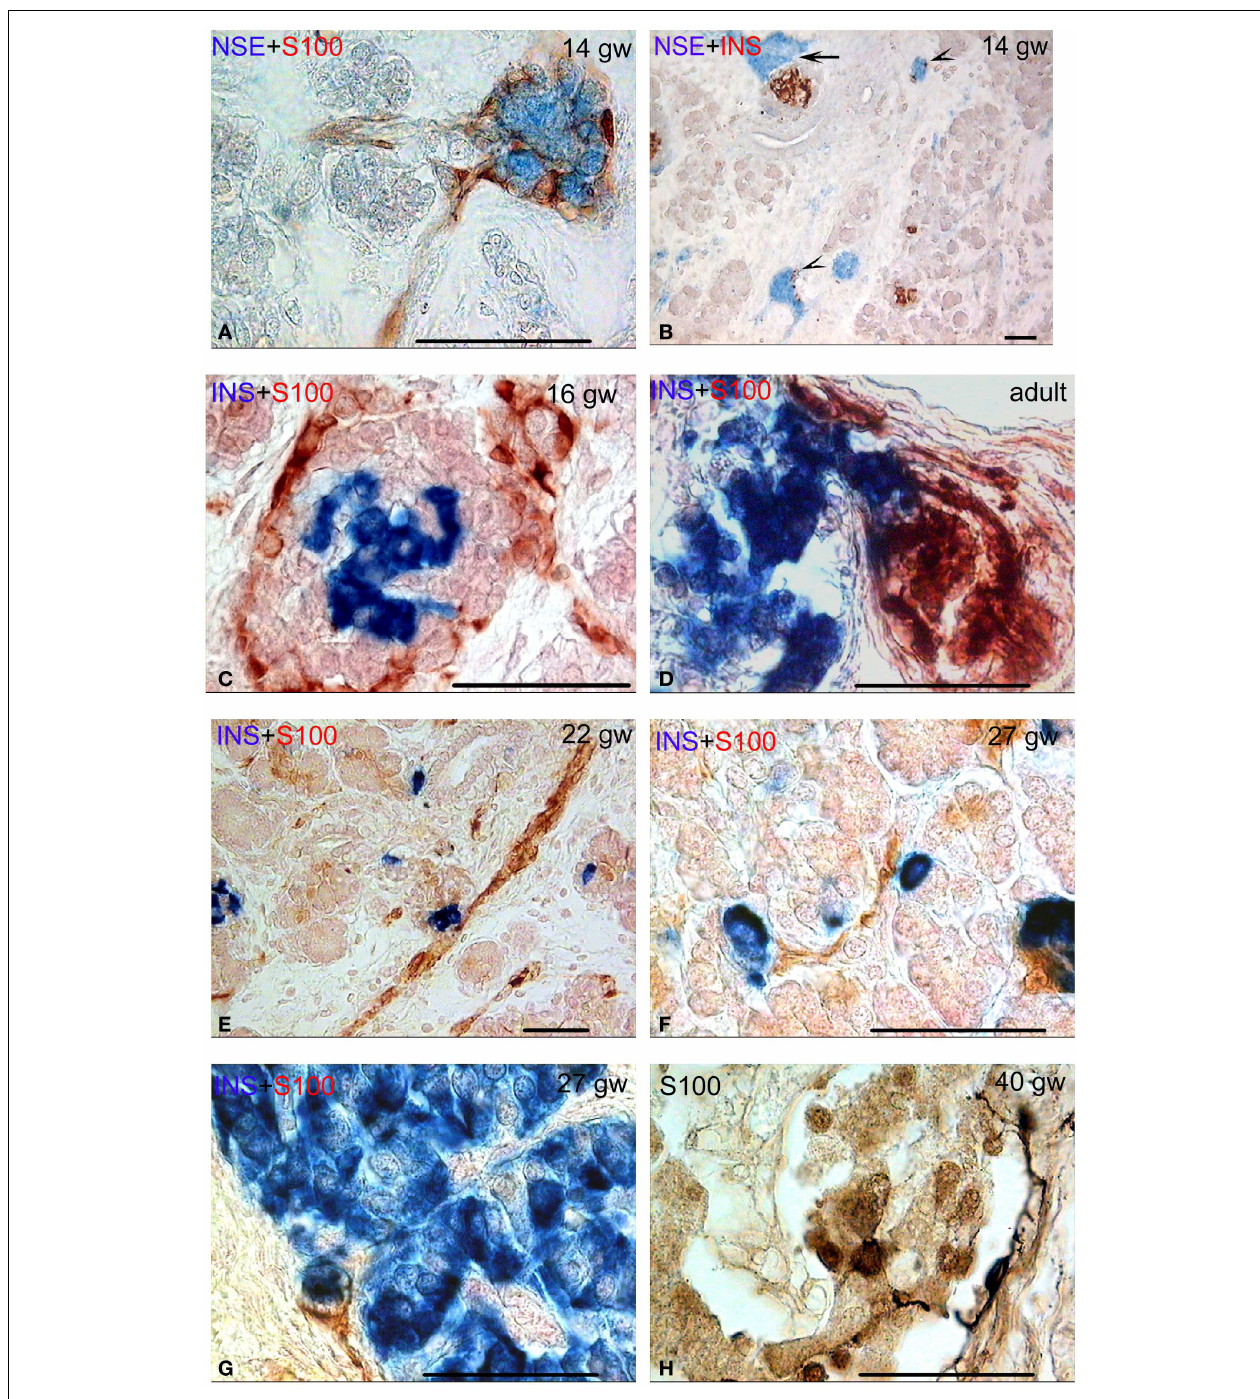
FIGURE 2 | Different types of connectivity between nervous system structures and pancreatic fetal and adult islets. Bar = 50mcm. (A) Autonomic ganglion (no endocrine cells) in human pancreas. NSE (blue) and S-100 (red) double staining. (B) Neuro-insular complexes type Ia (few endocrine cells in ganglion, arrow heads) and neuro-insular complex type I (the connection of the ganglion and the islet, arrow). NSE (blue) and insulin (red) double staining.